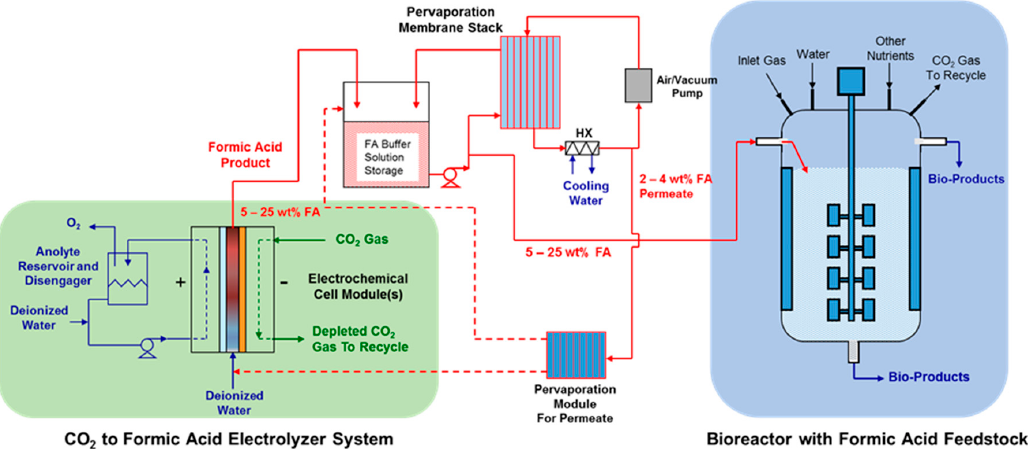
Figure 11. Conceptual system using the electrochemical FA cell integrated using pervaporation units